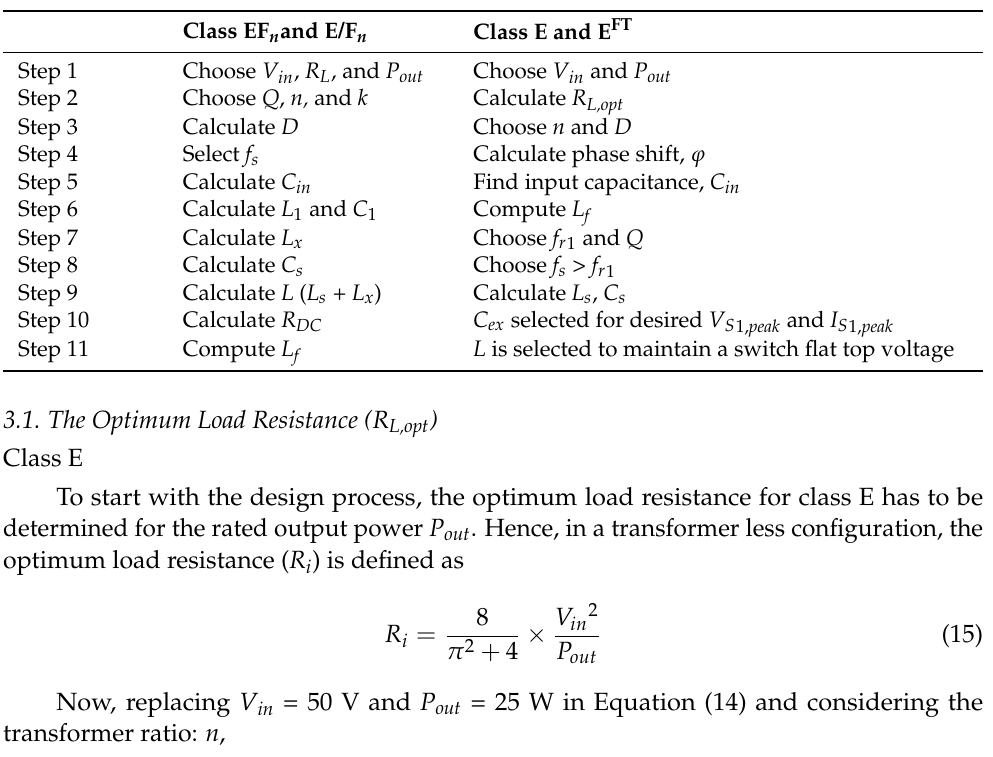
Table 3. The design methodology of the class E, EF n , and E/F n inverters